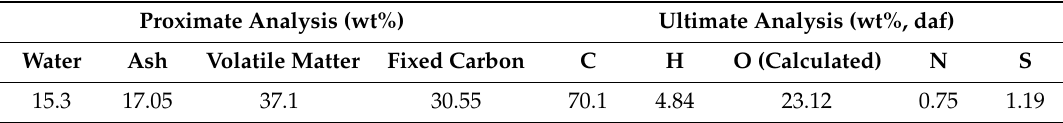
Table 1. Proximate and ultimate analyses of the char samples, oxygen calculated by di ff erence. Proximate Analysis (wt%) Ultimate Analysis (wt%, daf)